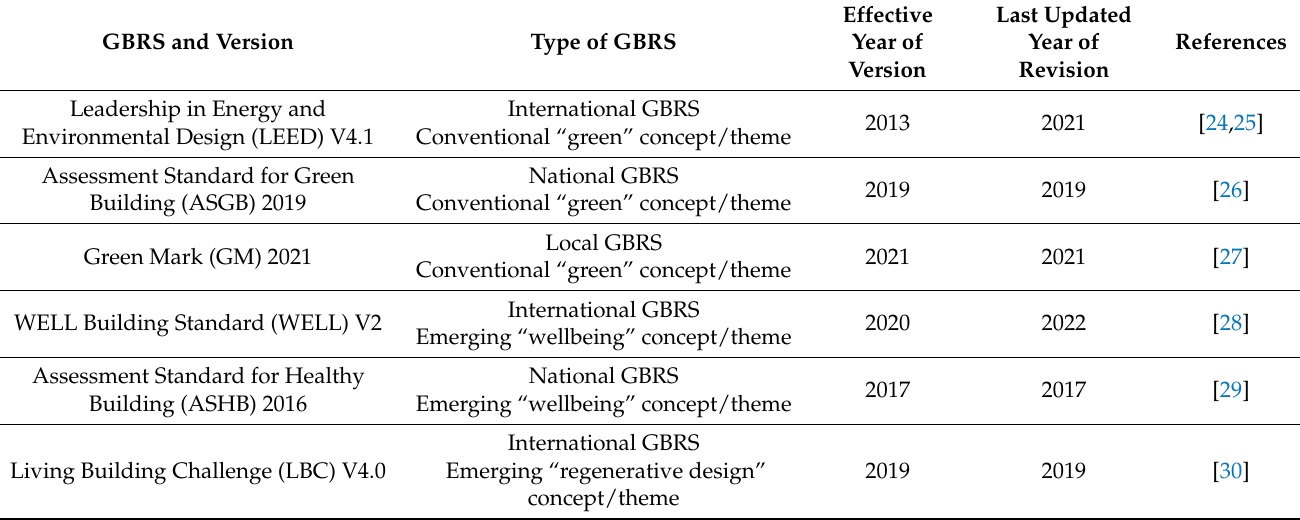
Table 2. Selected GBRSs of this study. (Source: by the